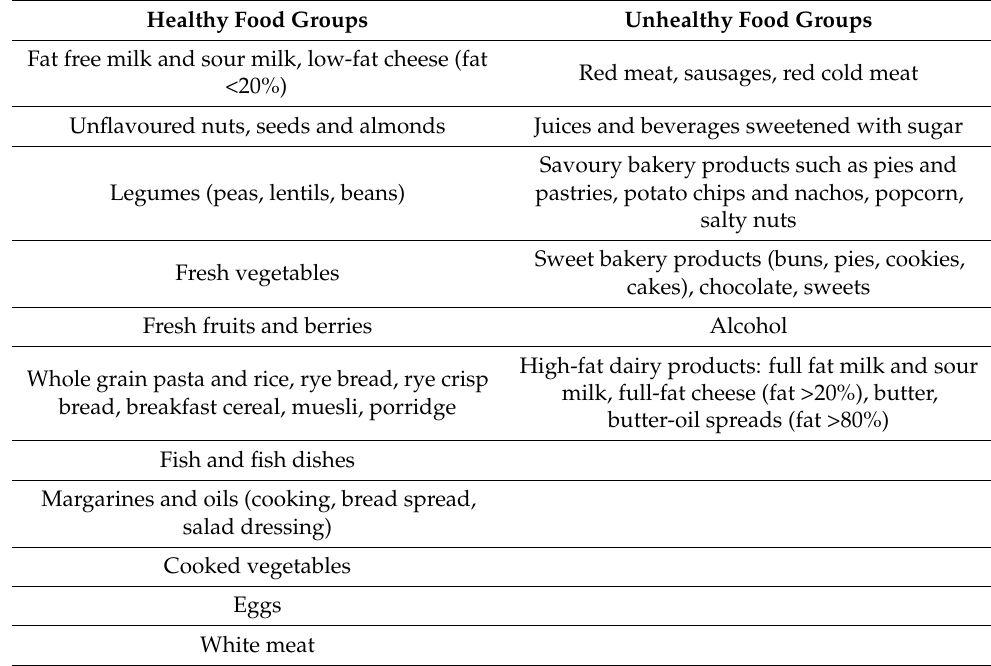
Table 1. Food groups considered healthy or